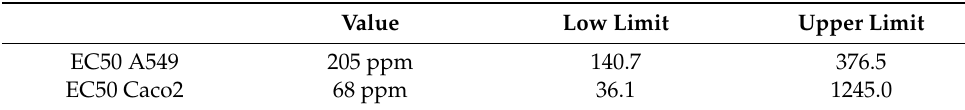
Table 8. Toxicity measured as EC50 values at 24 and 48